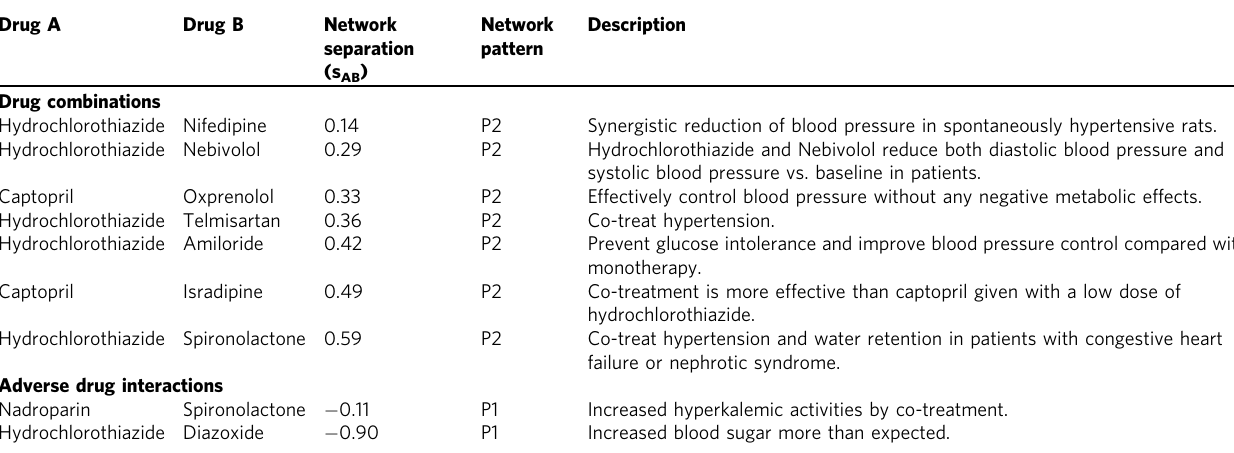
Table 1 Network con fi gurations of the selected hypertensive drug – drug pairs Drug A Drug